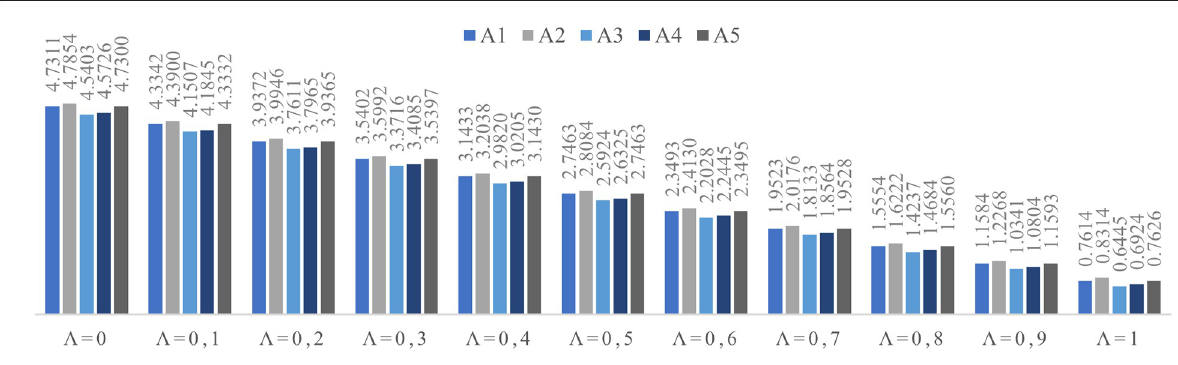
Fig 2. Rank of the alternatives when λ is between intervals 0 and 1 (Source: Authors).